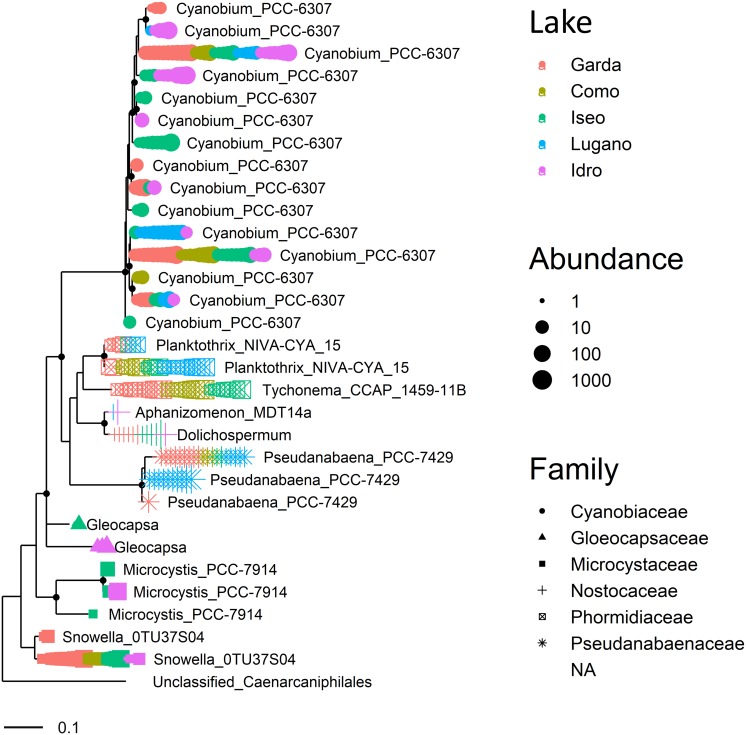
Maximum likelihood (ML) rooted topology of cyanobacteria identified at least at the genus level in the 5 lakes based on alignment of 16S rRNA gene fragments; the tree is rooted by an outgroup member of non-photosynthetic cyanobacteria (unclassified Caenarcaniphilales, Melainabacteria). Each symbol on the tip of the tree corresponds to a single sample; different symbols and colors correspond to the cyanobacterial families (with the exclusion of the outgroup, “NA”) and to the 5 lakes, respectively; the size of symbols is scaled according to abundance. The small black filled circles at the nodes indicate corresponding branch support aLRT-SH-like (Anisimova and Gascuel, 2006) values > 0.85.